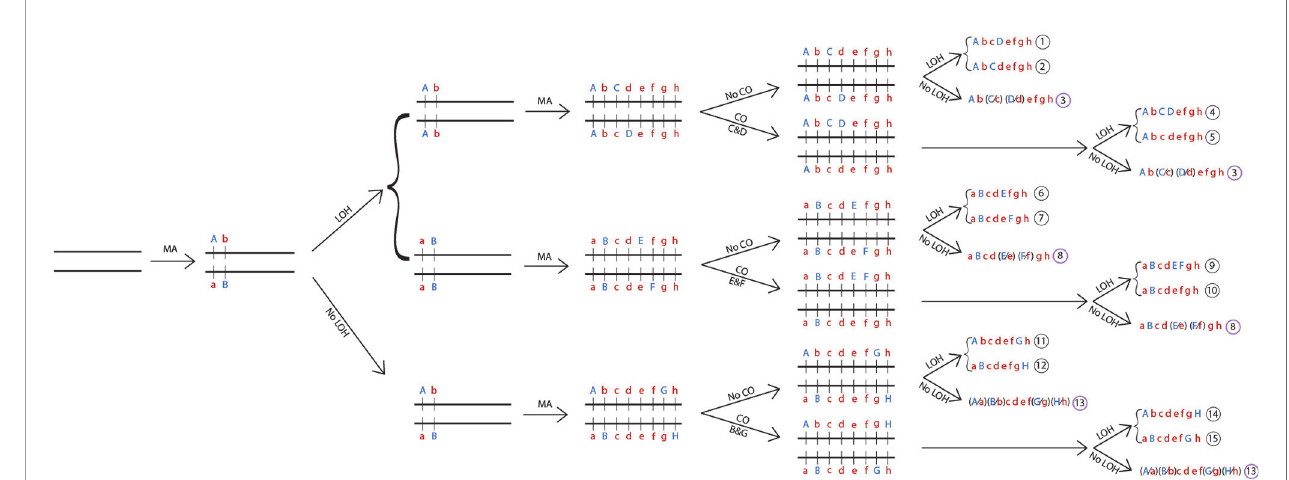
FIGURE 1 | Generation of recombinant genotypes and heterozygosity variations among strains of Candida tropicalis through asexual reproduction. Shown here is a single pair of homologous chromosomes completely identical to each other at the beginning and how three processes introduced during asexual reproduction at various stages can lead to the generation of a diversity of recombinant genotypes and heterozygosity patterns among their asexual progenies. The three processes are mutation accumulation (MA), loss of heterozygosity (LOH) through chromosomal loss, and mitotic crossing-over (CO) between different SNP pairs (C & D; E & F; and B & G). The asexual reproduction shown here generated 12 haplotypes and 15 composite diploid genotypes for this chromosome. At each of the eight SNP sites, both homozygous and heterozygous genotypes are found. In addition, there are six recombinant haplotypes 4, 5, 8, 9, 14, and 15. The capital letters A, B, C, D, E, F, G, and H indicate the newly accumulated mutated nucleotides while small letters a, b, c, d, e, f, g, and h indicate the ancestral